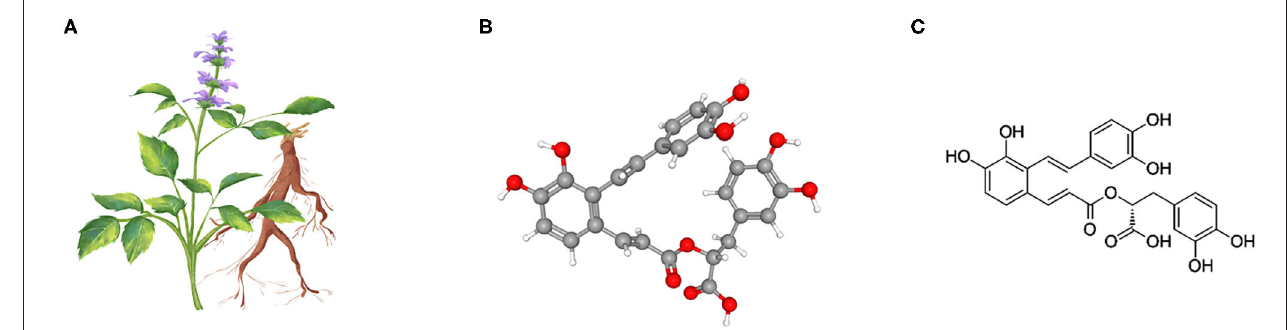
FIGURE 1 | Salvia miltiorrhiza and the chemical structure of its key active component Salvianolic acid A (Sal A). (A) Illustration of Salvia miltiorrhiza and the medicinal root; (B) As the most abundant water-soluble active component extracted from Salvia miltiorrhiza , Sal A is a rosmarinic acid derivative and a member of the class of 1-benzofurans. The 3-D view of the conformer of Sal A; (C) The 2-D view of the chemical structure of Sal